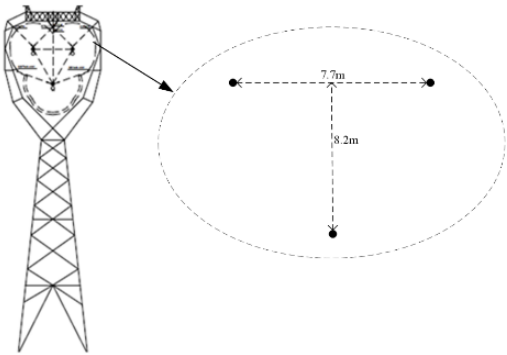
Figure 4. Schematic diagram of the three-phase overhead line layout.